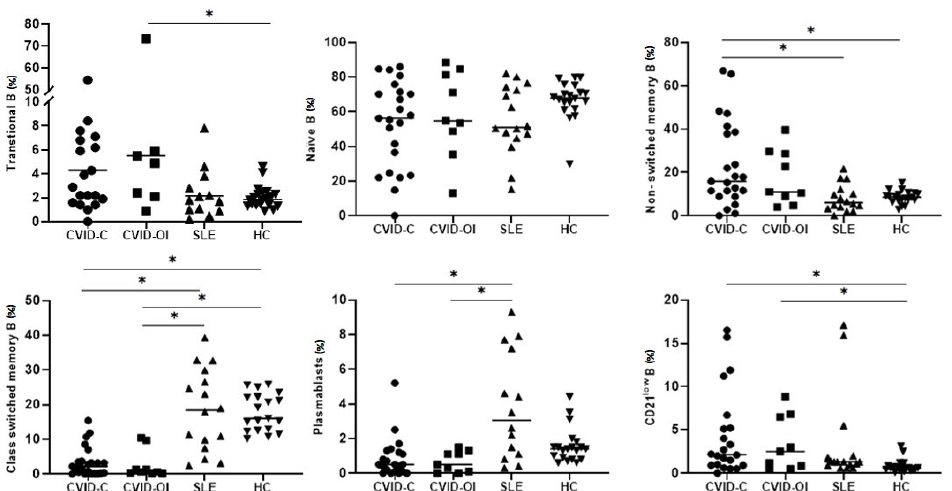
Figure 3. Differences in the proportions of B lymphocyte maturation between the CVID with complicated phenotype (CVID-C) group, CVID phenotype limited to only infections (CVID-OI group), patients with systemic lupus erythematosus (SLE), and healthy controls (HCs). Data expressed as median (Q1–Q3), * p <